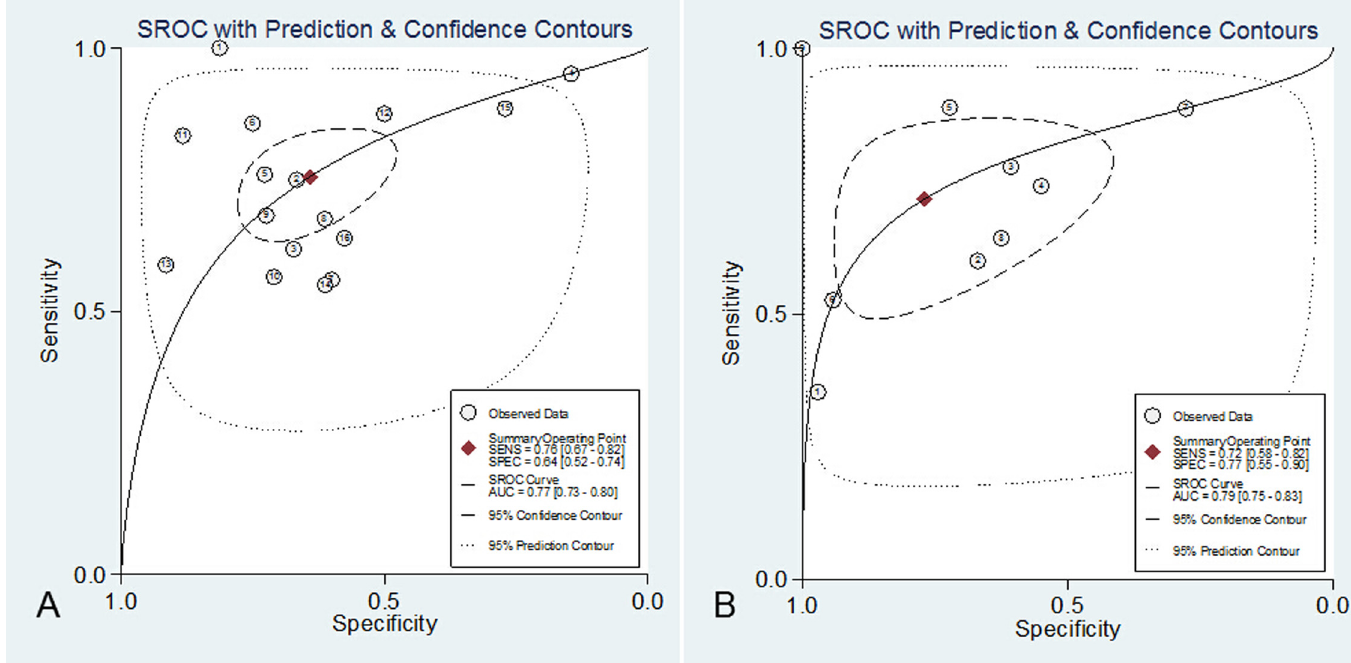
Fig 4. Summary receiver operating characteristic graph of the included studies (A. For single procalcitonin concentration; B. For procalcitonin non- clearance).